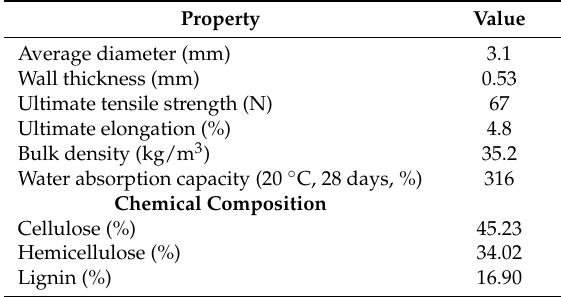
Figure 1. Photographs of wheat straw fibers: ( a ) natural wheat straw fibers, ( b ) peeled wheat straw fibers, and ( c )wheat straw fibers trimmed to the required shape and length. Table 2. Basic properties of wheat straw fibers.